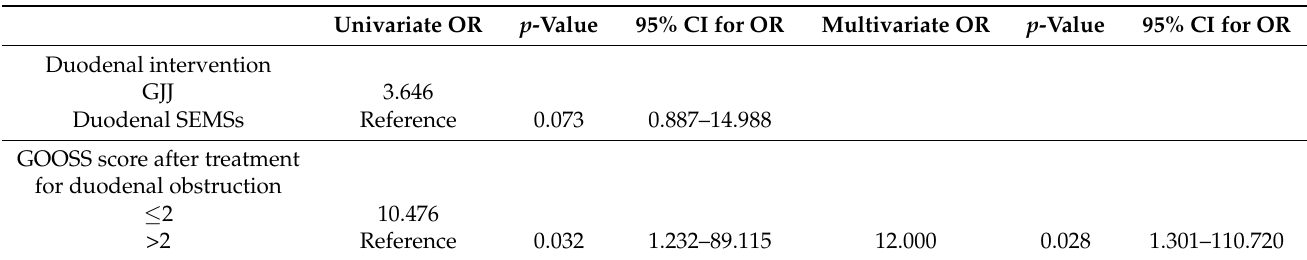
Figure 1. Kaplan–Meier curve showing time to duodenobiliary reflux (DBR)-related covered biliary self-expandable metal stents (SEMS) dysfunction according to the obstruction site of the duodenum.